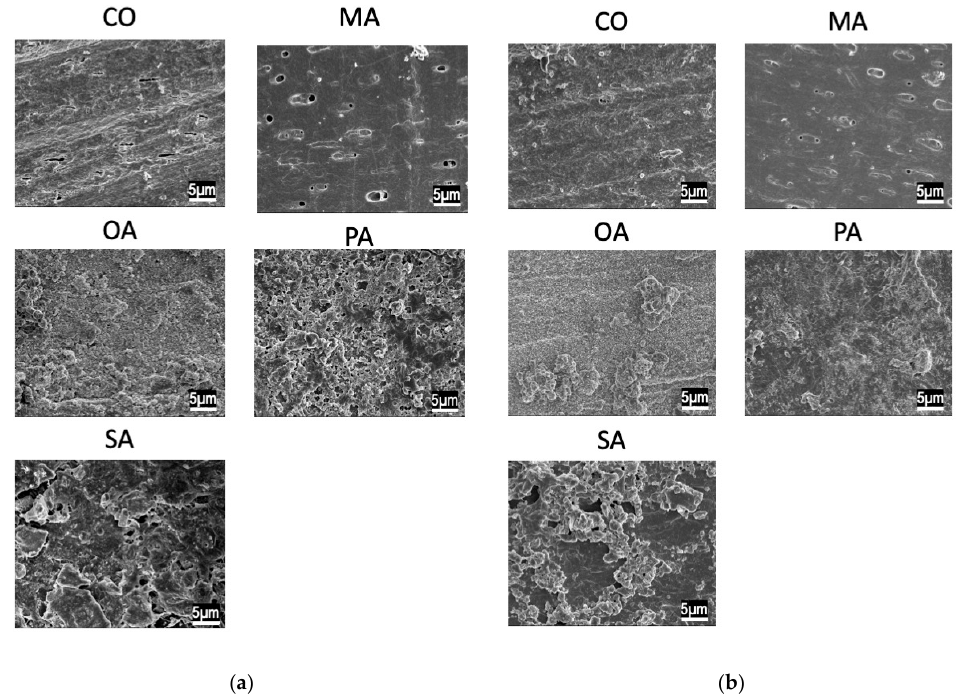
Figure 3. SEM images of each group before pH-cycling. ( a ) Deionized distilled water wash, ( b ) remineralization solution wash ( × 3000).